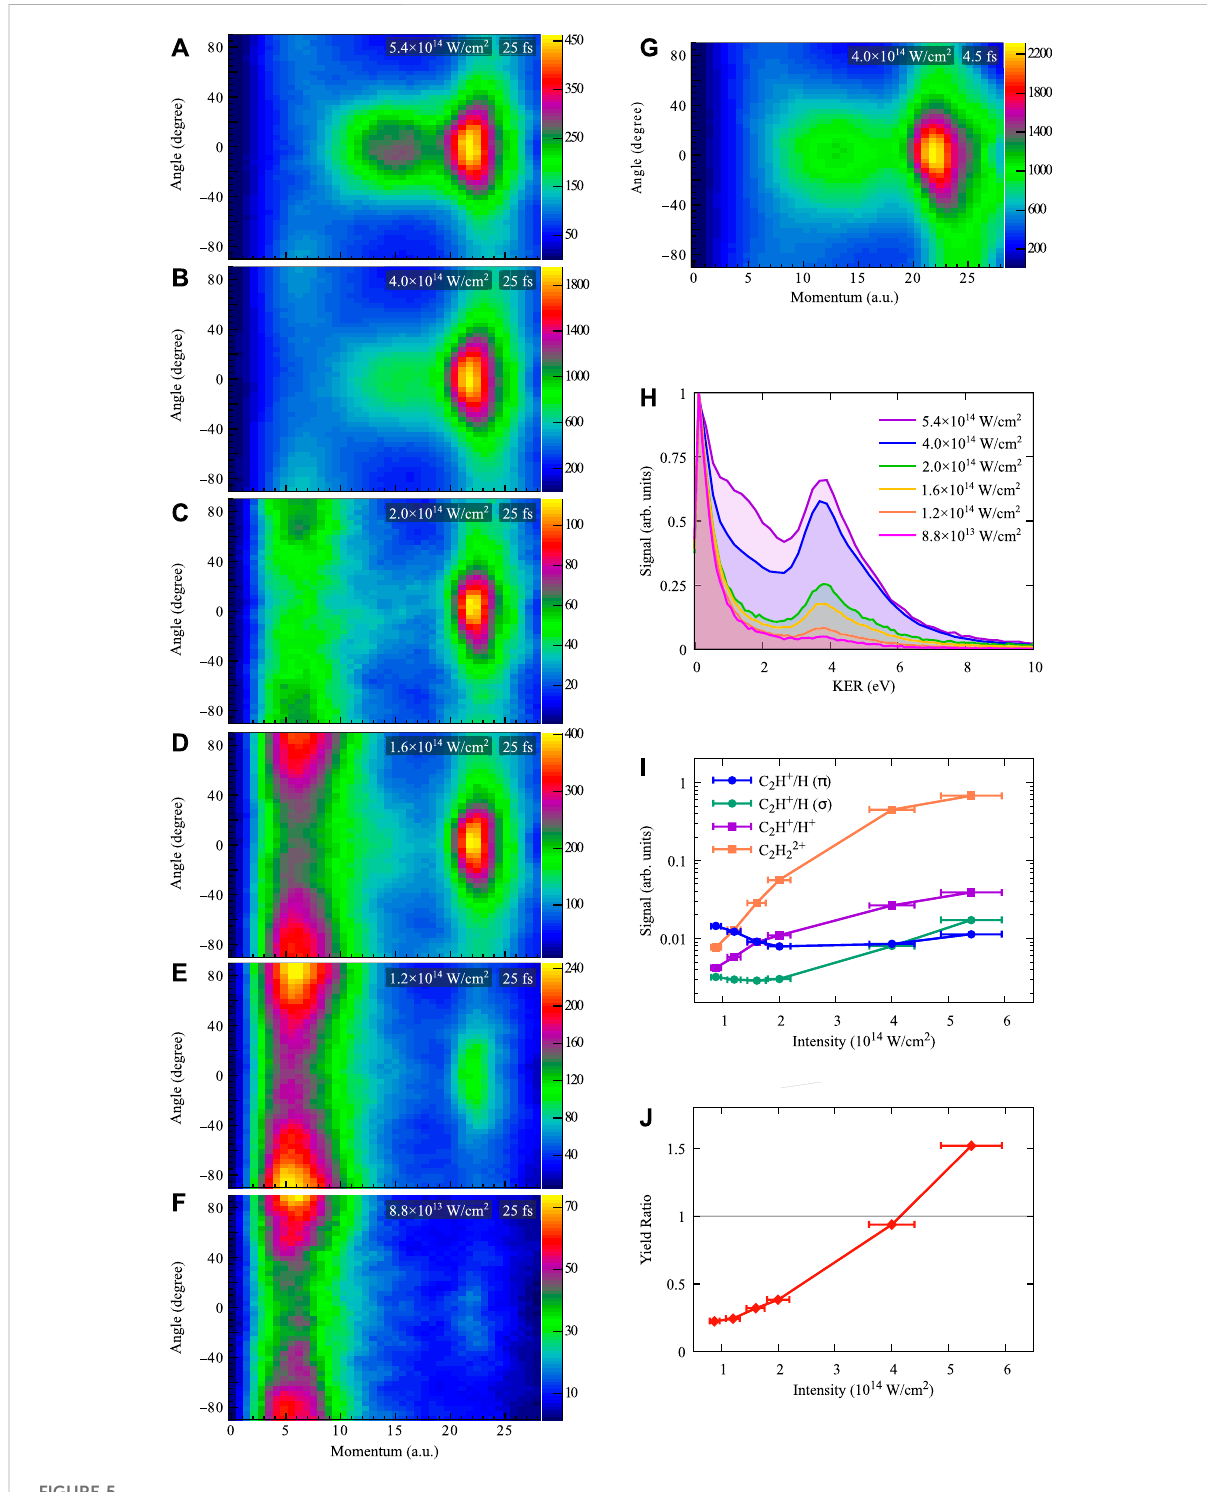
FIGURE 5 Measured ion signal distributions over the momentum and the angle to the laser polarization direction for different laser peak intensities with the pulse duration of 25 fs (A – F) and 4.5 fs (G) . (H) Normalized kinetic energy distributions of the molecular dissociation for different laser peak intensities with the pulse duration of 25 fs. (I) Ion yields for different ionization and dissociation channels over laser intensity normalized to the non- dissociative single ionization signal (C 2 H + 2 ). (J) The ion yield ratio between the direct (HOMO-2) and indirect (HOMO) dissociative single ionization over laser